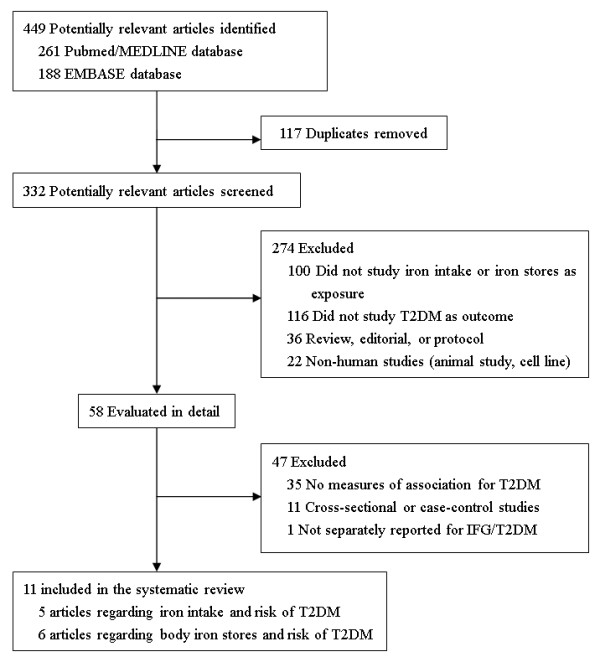
Flow chart for study selection (through April 22, 2012).